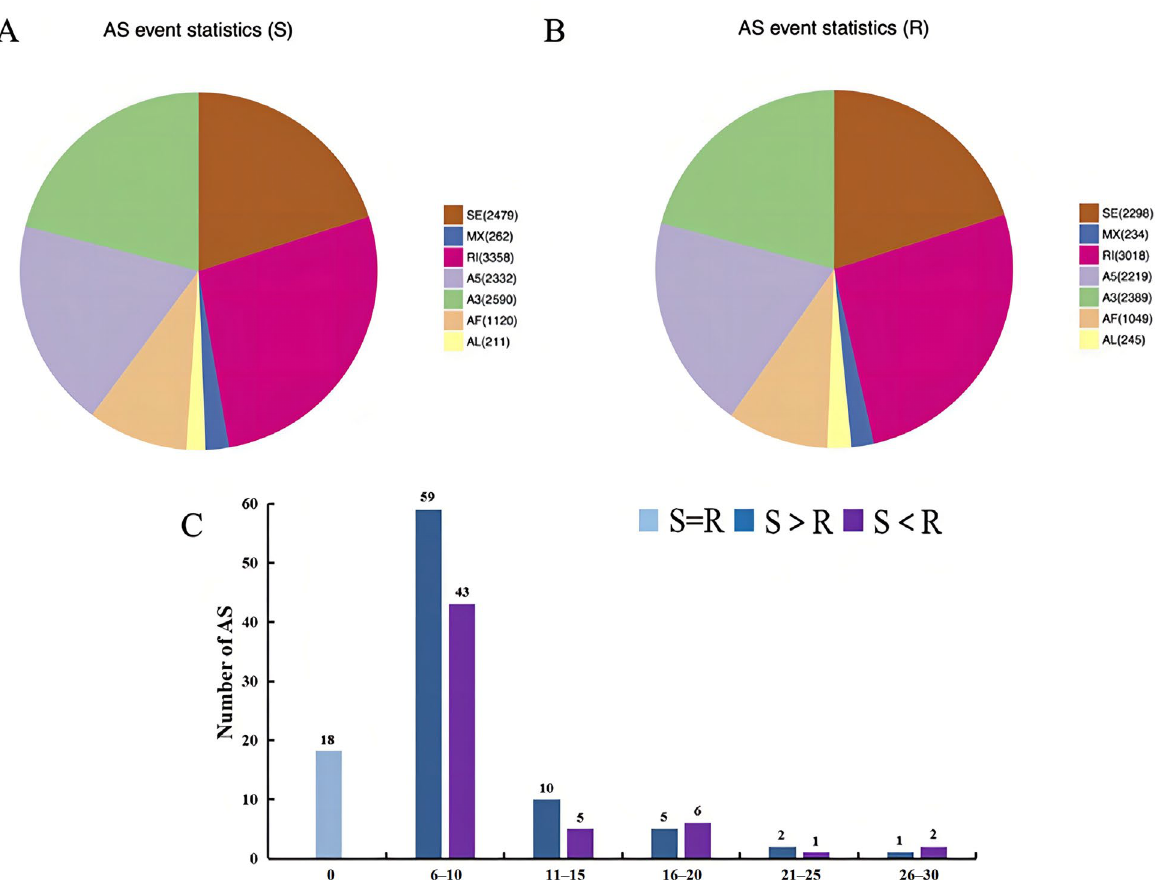
Figure 9. Alternative splicing (AS) analysis of the full-length transcriptome of CSBV Bces-Po19-sensitive and -resistant Japanese flounder ( Paralichthys olivaceus ). ( A ) AS events statistics of CSBV Bces-Po19-sensitive (S) group. ( B ) AS events statistics of CSBV Bces-Po19-resistant (R) group. ( C ) Com- parison of the number of different AS in genes between CSBV Bces-Po19 S and R group. A comparison of CSBV Bces-Po19 S and R groups revealed 152 genes with varying amounts of AS. In 57 of these 152 genes, the R group had more AS than the S group, while the S group had more AS than the R group in the other 77 genes (Figure 9C). The tead3 gene had the most AS in the R group, with 52 AS, which is 25 higher than the S group. The highest number of AS was found in the S group in the slco4a1 gene, which contained 57 AS, which is 21 more than the R group (Table 4).